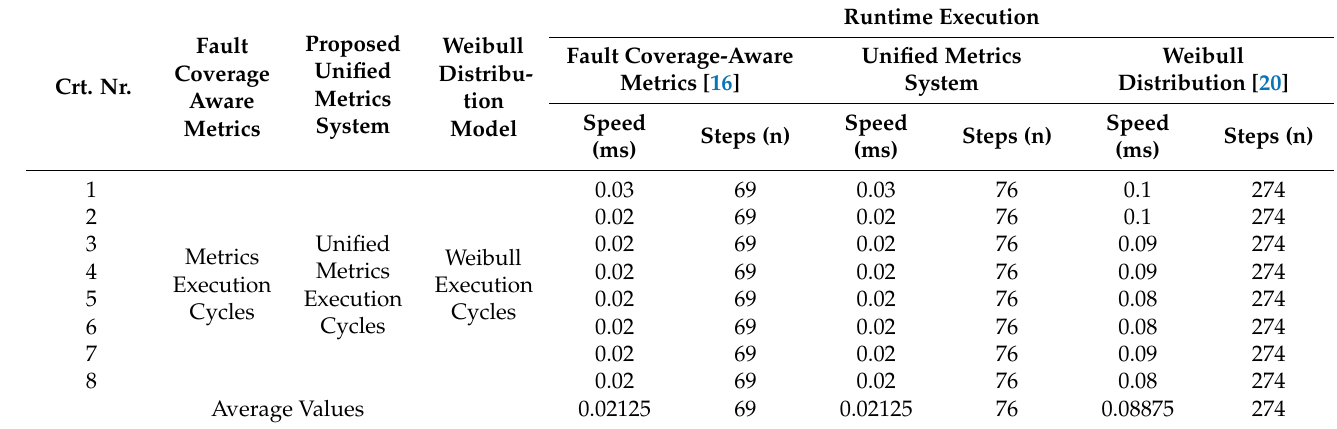
Table 3. Comparison between the fault coverage-aware metrics, proposed unified metrics system and Weibull distribution model regarding calculation steps and execution time [20]; adapted from [16].